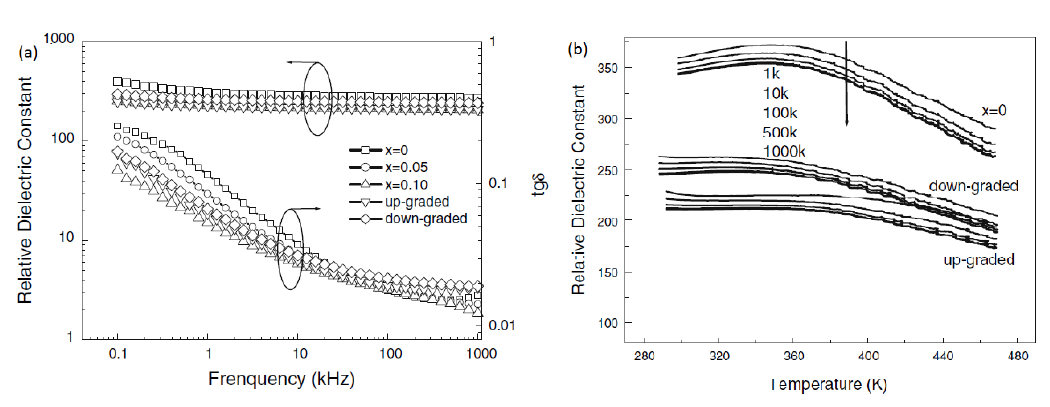
Figure 13. Dielectric constant and loss of (Ba,Ca)(Zr,Ti)O 3 thin films on Pt/TiOx/ SiO 2 /Si substrates crystallized at 700 °C as a function of the measured frequency, ( a ) Ba:Ca = 1.0:0.0 ( ▲ , △ ) and ( b ) Ba:Ca=0.95:0.05 ( ■ , □ ) [Zr: Ti = 0.20:0.80] (a). Temperature dependence of dielectric constant and loss of (Ba,Ca)(Zr,Ti)O 3 thin film on Pt/TiOx/SiO 2 /Si substrate crystallized at 700 °C (measured frequency: 1 – 100 kHz) [Ba:Ca = 0.95:0.05, Zr:Ti = 0.20:0.80] (b). Reprinted with permission from [90] . Copyright 2008 Elsevier. L.L. Jiang et al. grew (BCZT) thin films on Pt/Ti/SiO 2 /Si substrates with and without a CaRuO 3 (CRO) buffer layer. The dielectric constant and tunability were 725 and 47.0%, 877 and 50.4%, respectively, for substrates without and with the CRO buffer layer. A higher dielectric constant and tunability were observed for Pt/BCZT/CRO capacitors [91]. C. J. M. Daumont reported on libraries of Ba 0.97 Ca 0.03 Ti 1_x Zr x O 3 thin films deposited on IrO 2 /SiO 2 /Si substrates and found maximum tunabilty at intermediate compositions of 60% for an electric field of about 400 kV cm – 1 [92]. Min Shi et al. prepared the lead-free thin films of BCZT on the Pt/Ti/SiO 2 /Si for different annealing processes. The annealing process, where the thin film is composed of a single phase with no trace of secondary phases with preferred orientation of (100), was found to be the best for preparing thin films of BCZT with good dielectric properties [93]. Valentin Ion et al. showed nontrivial dependence on film